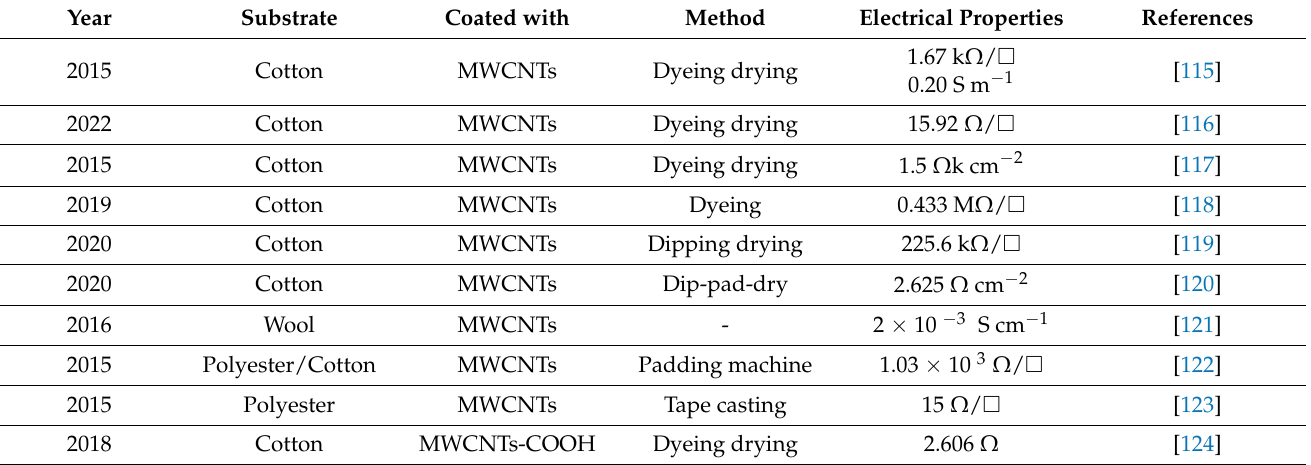
Table 5. Summary list of MWCNTs-based materials with details of their manufacturing processes and electrical